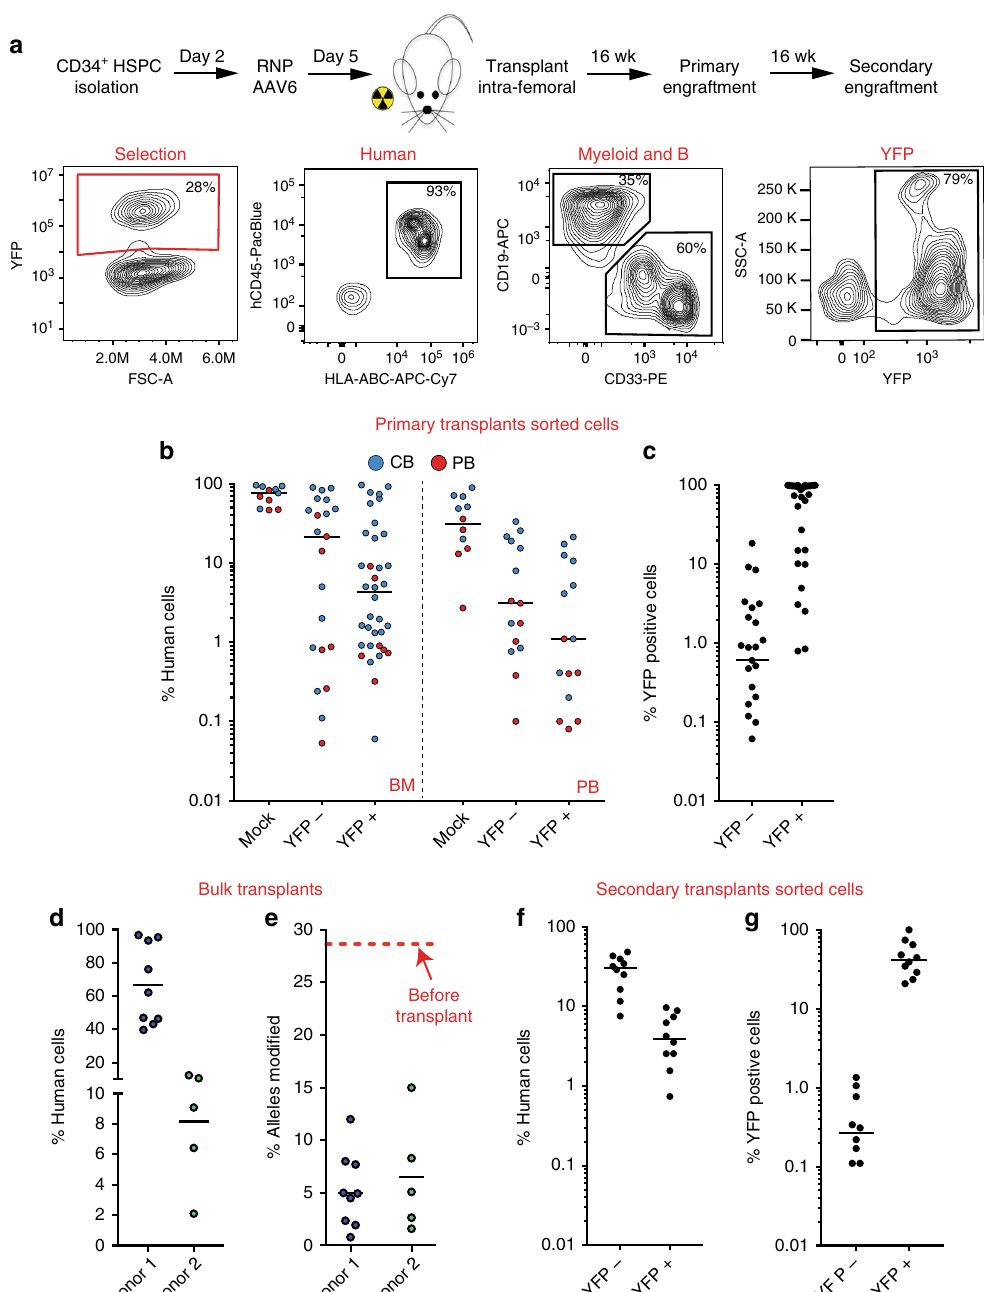
Fig. 3 IDUA-HSPCs maintain long-term repopulation capacity. a Schematic and representative FACS plots showing phenotyping by fl ow of human, myeloid, B-cell, and targeted cells after engraftment. b Percent human cell chimerism in bone marrow (BM) and peripheral blood (PM) of mice 16-weeks post- transplant with CB (blue dots) and PB (red dots)-derived HSPCs targeted with PGK-IDUA-YFP cassette. Each point represents an individual mouse; mock ( n = 11), YFP- ( n = 21), and YFP + ( n = 36). c Percent human, YFP + cells in BM of mice in BM 16-weeks post-transplant. d Percent human cell chimerism in BM in mice transplanted with bulk cells without selection with two different human cell donors; donor 1 n = 9, donor 2 n = 5 e Percent modi fi ed alleles in engrafted cells by ddPCR. 28% was the starting allele modi fi cation frequency for both human donors. f Percent human cell chimerism in BM of mice in secondary transplants 32 weeks after genome editing; YFP- ( n = 10), and YFP + ( n = 10). e Percent human, YFP + cells in BM of mice in secondary